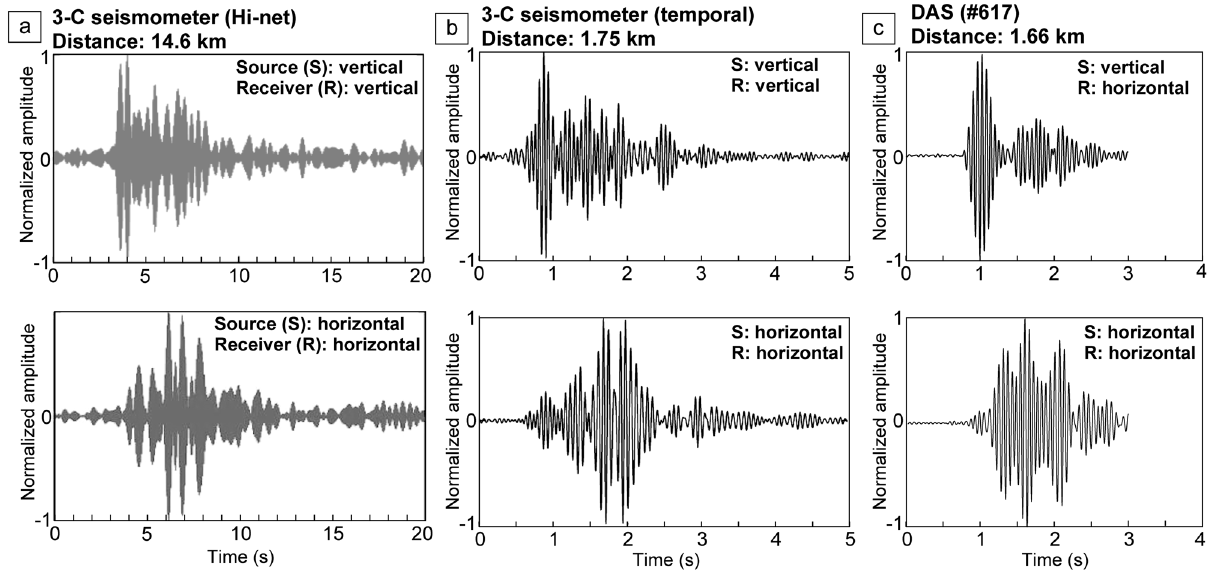
Figure 4. Monitoring signals received by two seismometers and DAS with different distances. ( a ) Transfer functions between the source and a Hi-net seismometer (14.6 km distance). ( b ) Transfer functions between the source and temporal seismometer (1.75 km distance). ( c ) Transfer functions between the source and a DAS record (channel #617). The upper and lower panels show the results from vertical and horizontal source motion,